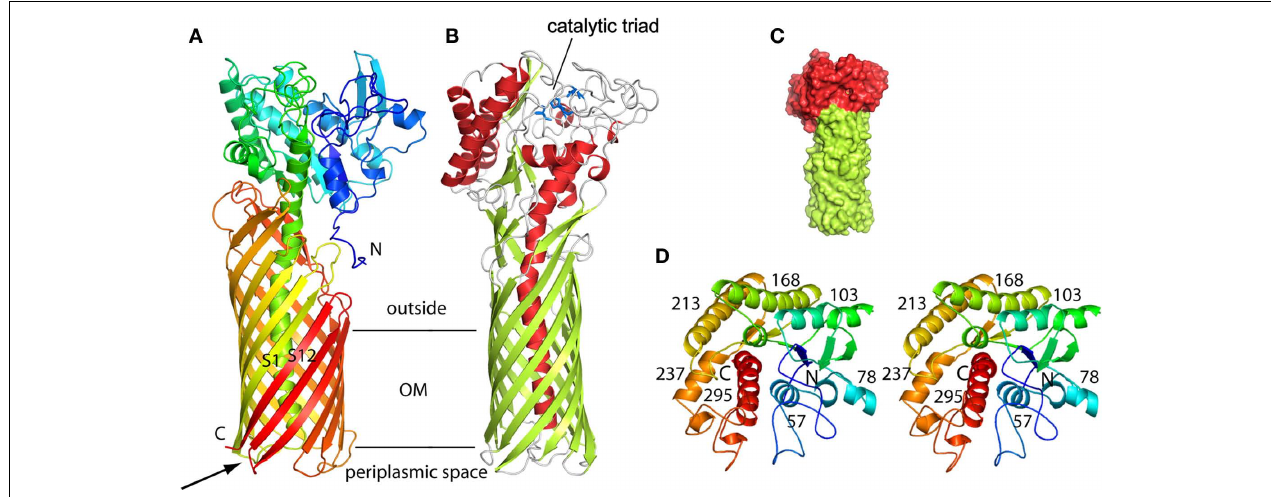
as blue stick models. Horizontal lines indicate the approximate location of the outer membrane core. (C) Surface view of EstA from the side with the β -barrel domain colored green and the passenger domain colored red. (D) Stereo view of the EstA passenger from the extracellular side, colored as a rainbow from dark blue at the N-terminus to dark red at the C-terminus.The numbers are those for the central residue of the α